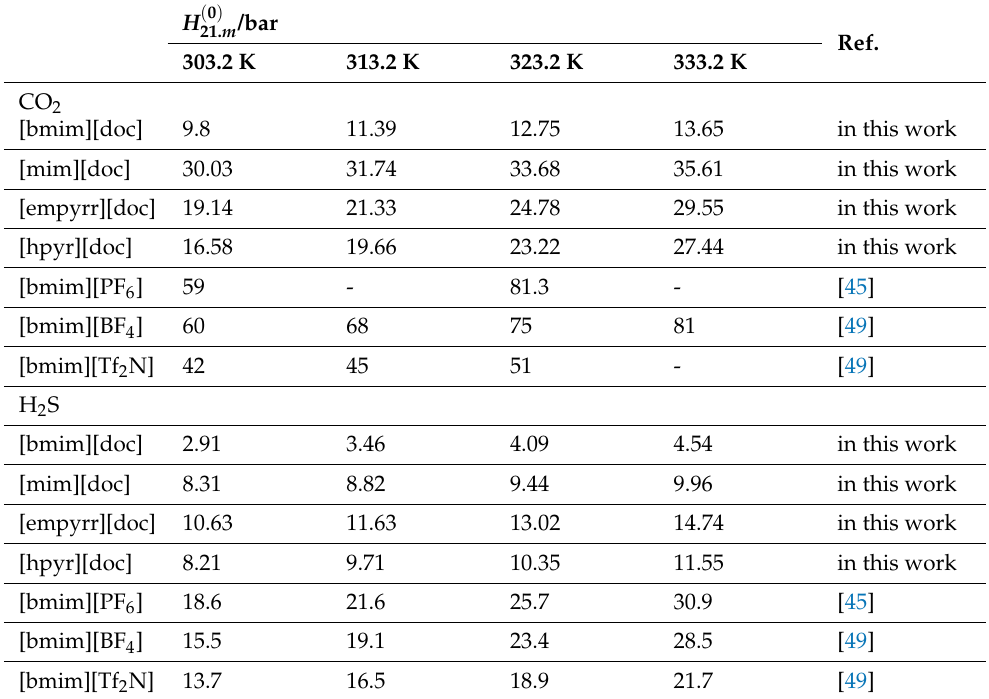
Table 5. The CO 2 and H 2 S Henry’s law